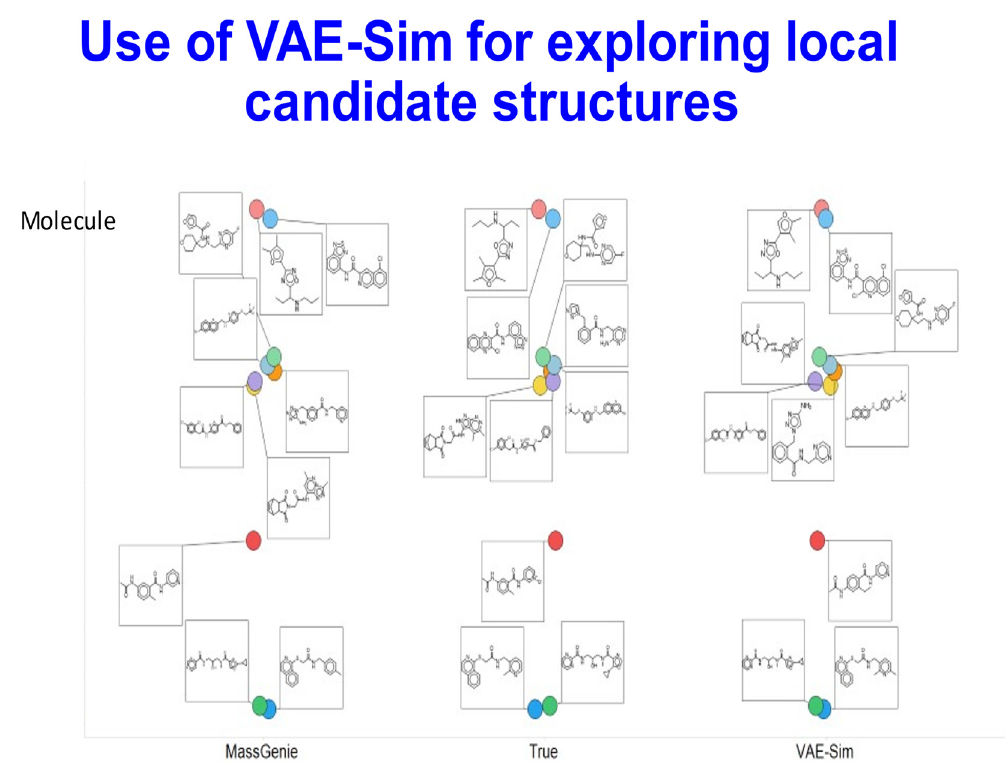
Figure 4. Local candidate structures generated by VAE-Sim. Based on 10 molecules taken from Figure 3, where the Tanimoto similarity between the best hit and the true molecule was in the range 0.9–0.95. VAE-Sim increases the number of candidates, in many cases improving their closeness to the true molecule.